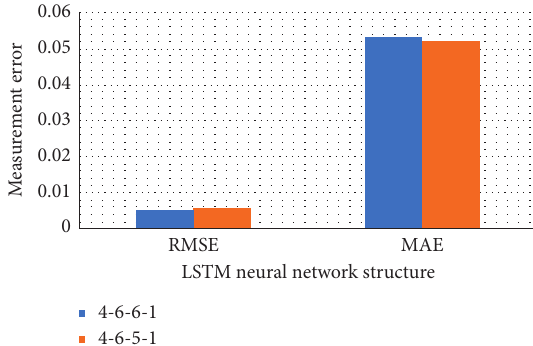
Figure 17: Comparison of two network structures.